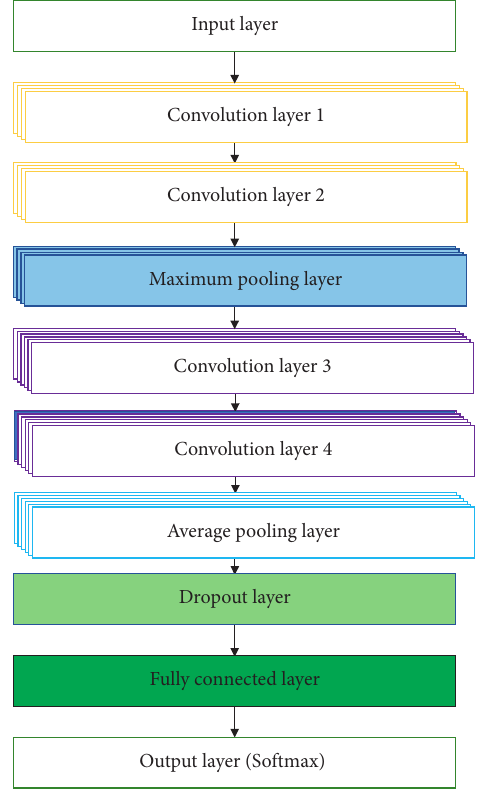
Figure 15: One-dimensional convolutional neural network structure.